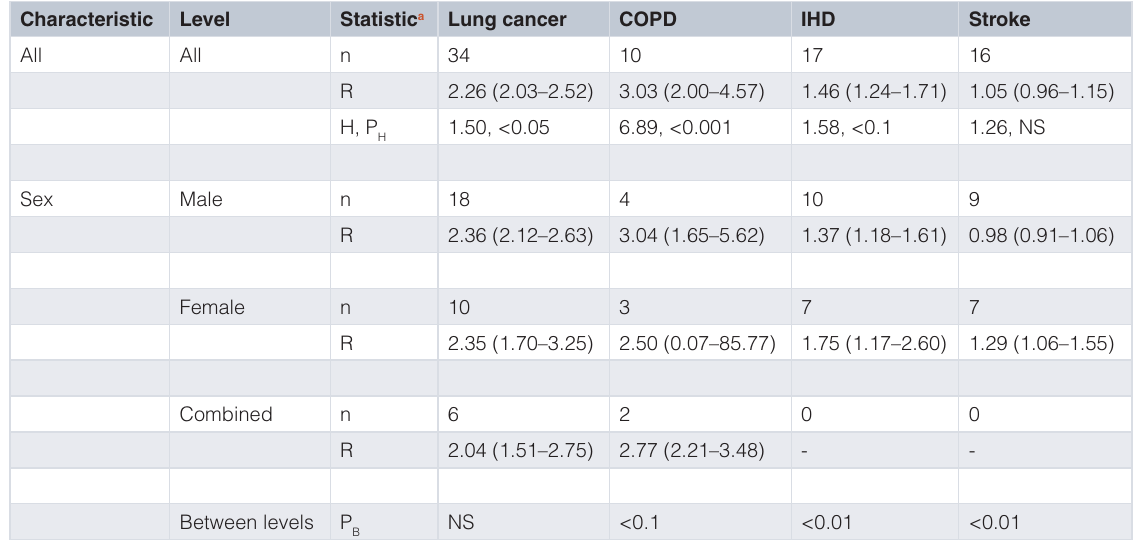
Table 5. Meta-analyses for